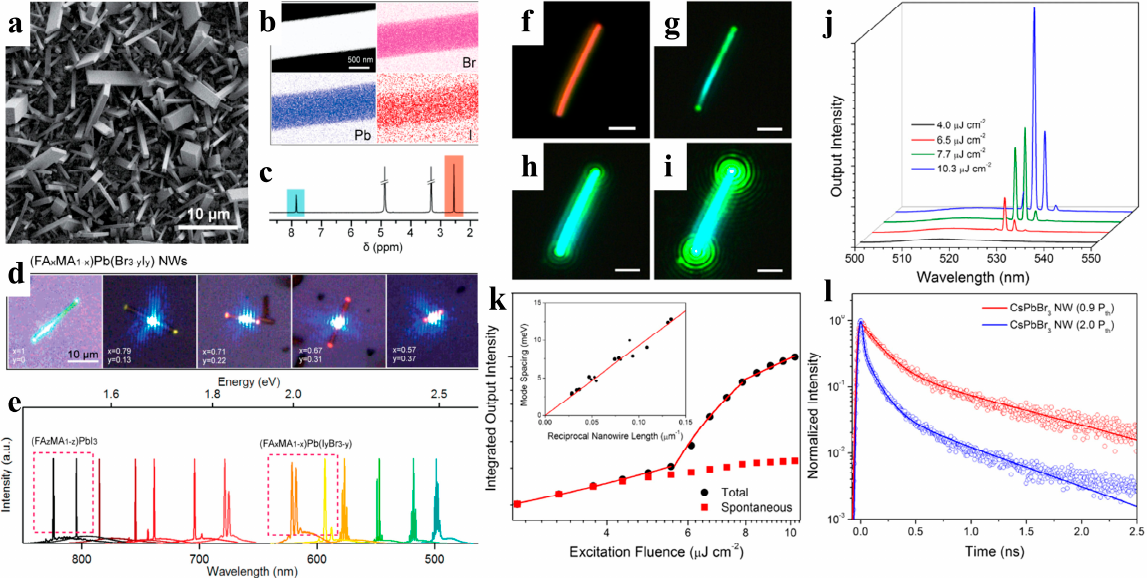
Figure 10. ( a ) SEM image of (FA 0 . 67 MA 0 . 33 )Pb(Br 2 . 69 I 0 . 31 ) NWs. ( b ) EDS mapping of a single NW. ( c ) 1H NMR spectrum showing the MA and FA in the NWs. ( d ) Optical images of (FA x MA 1‑x )Pb(Br 3‑y I y ) NWs excited by a laser with a 442 nm wavelength. ( e ) Broad